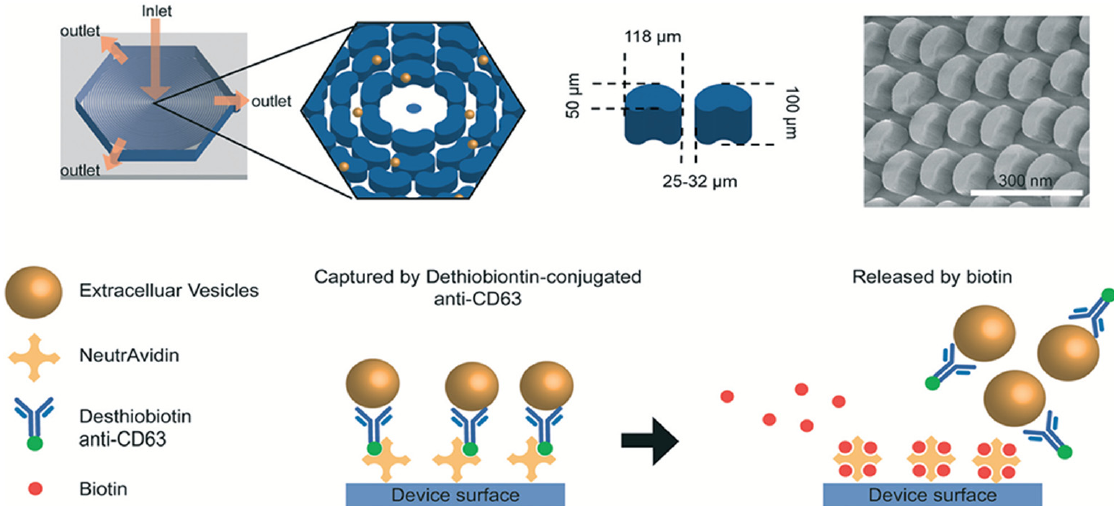
Figure 4. Schematic showing features and functionality of the OncoBean Chip. Width, length, and height of posts were 50, 118, and 100 µ m, respectively, with an interpost distance of 25–32 µ m. NeutrAvidin is used to coat the surface of the device, which helps in the incorporation of desthiobiotin- conjugated antibodies required for recognition of surface markers of EVs. Biotin is used for the release of the desthiobiotin-antibody-EV complex and effectively allowing for collection of EVs. Reprinted from [108] with permission from the Royal Society of Chemistry.